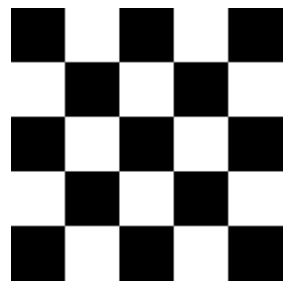
Figure 8. The white and black squares are perfectly dispersed. On Figure 8. we illustrated a very odd distribution of two alternating land cover types (chessboard), with maximal heterogeneity and border sum. It would yield to a maximum potential if our agents did not have a memory, i.e. they could revisit the same land cover type many times. This would be clearly useless, because this regular chessboard type landscape cannot be viewed as a very diverse one. This regular pattern could be merged into each other on the ground. Considering all these, we have chosen a dynamic method which is the agent-based modelling.